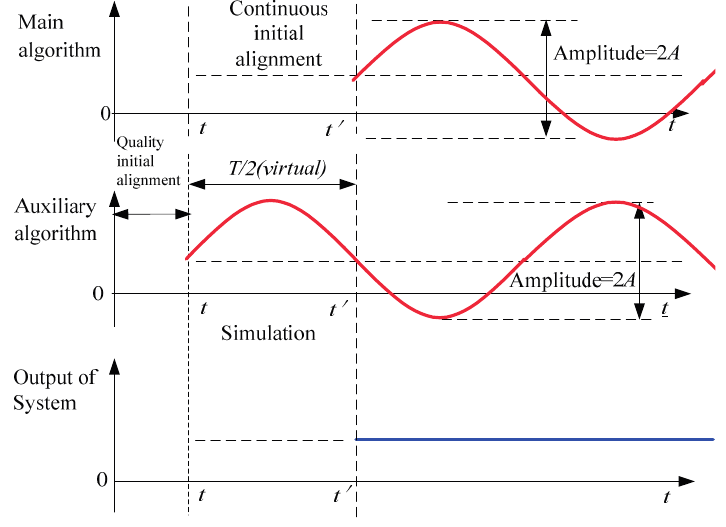
Figure 2. Principle diagram of suppressing oscillation errors based on forecasted time